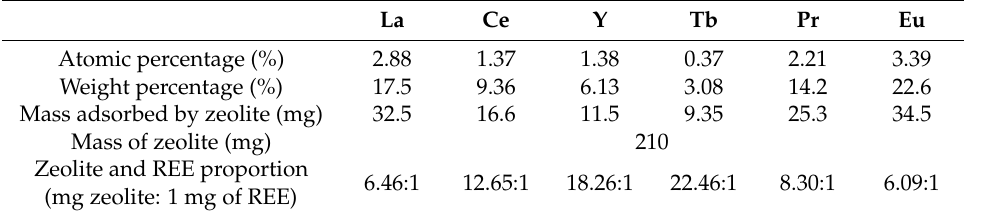
Table 3. Atomic and weight percentage for the SEM/EDS analyses of zeolite with individually adsorbed REE. La Ce Y Tb Pr Eu Atomic percentage (%) 2.88 1.37 1.38